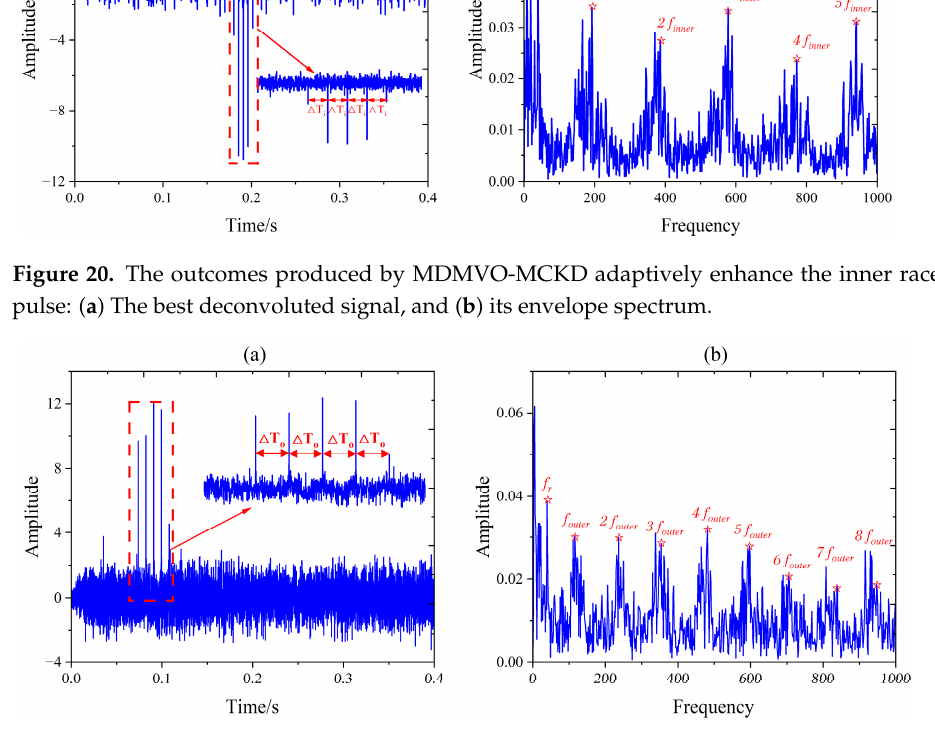
Figure 22. The outcomes produced by MDMVO-MCKD adaptively enhancing the roller fault pulse: ( a ) The best deconvoluted signal, and ( b ) its envelope spectrum.